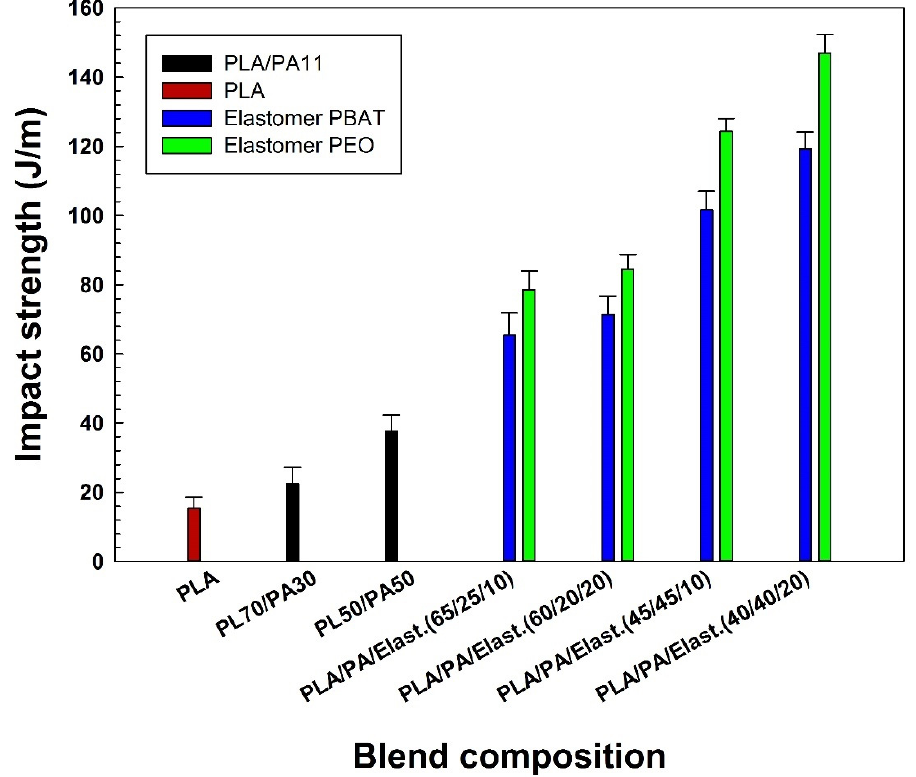
Figure 8. Impact strength of the blends (see Section 3.2 for definition).